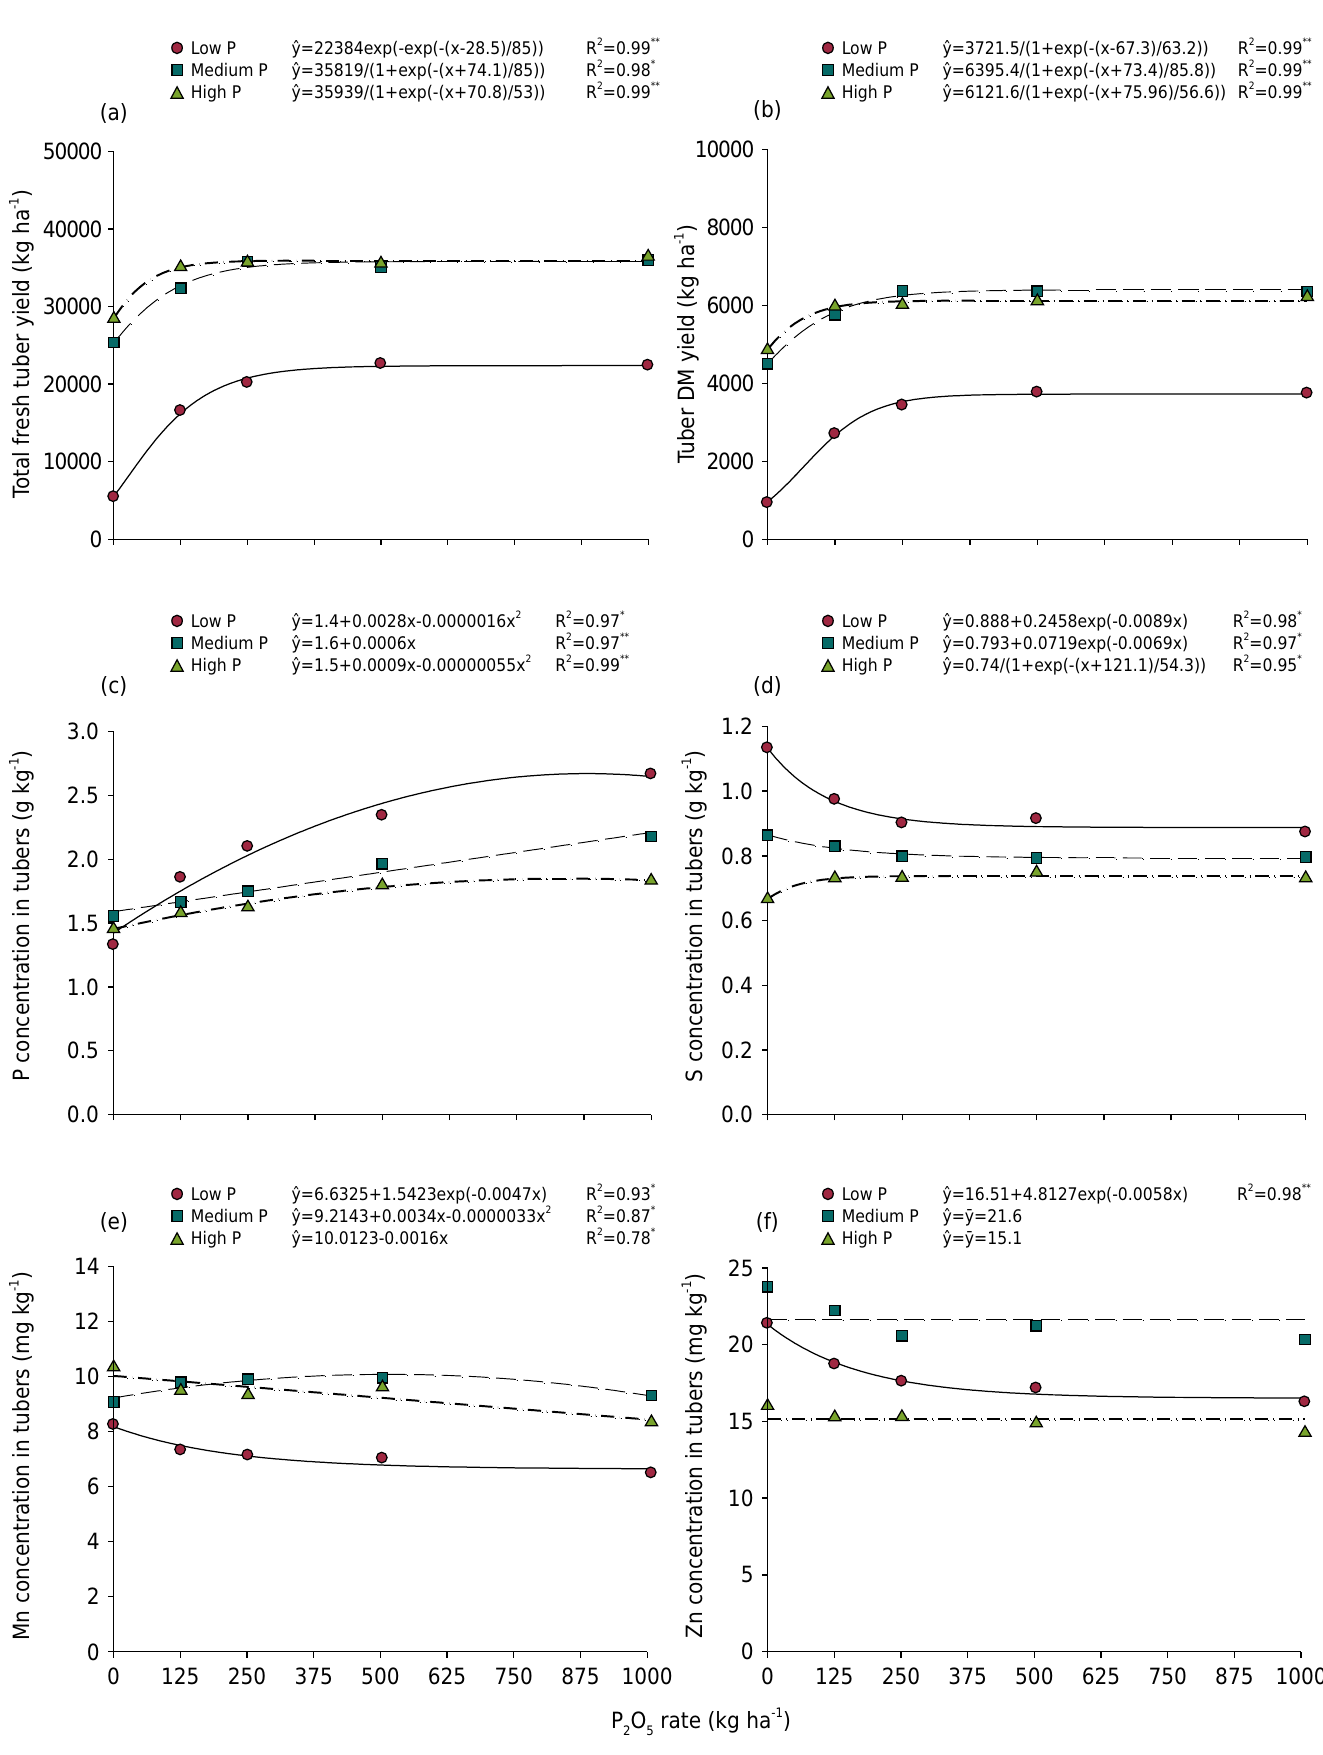
Figure 5. Total fresh tuber yield (a), tuber dry matter (DM) yield (b), and concentrations of P (c), S (d), Mn (e), and Zn (f) in potato tubers as affected by rates of P applied in the planting furrow in soils with low, medium, and high P availability. Means of five cultivars. * and ** : significant at 5 and 1 % by the F